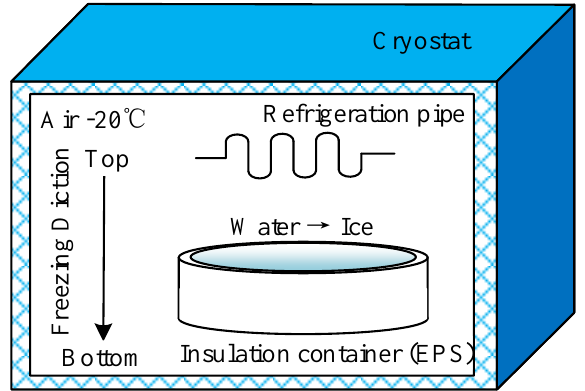
Figure 3. Schematic diagram of ice-making in the cryostat.